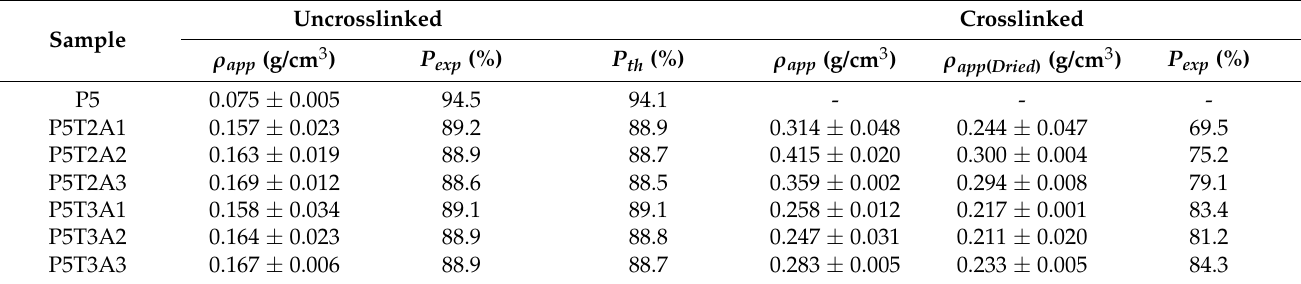
Table 1. Apparent densities and experimental and theoretical porosity of PVA/TA/SA uncrosslinked and crosslinked